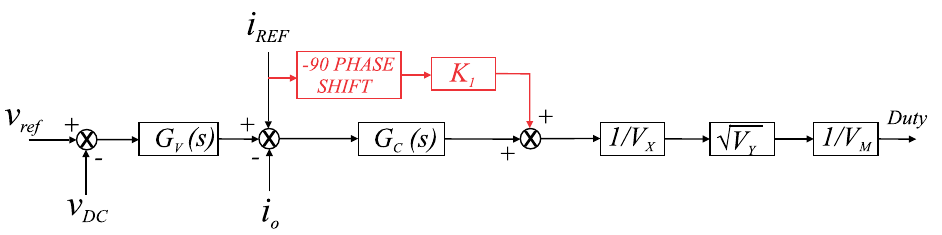
Figure 21. A feedforward control scheme [99].